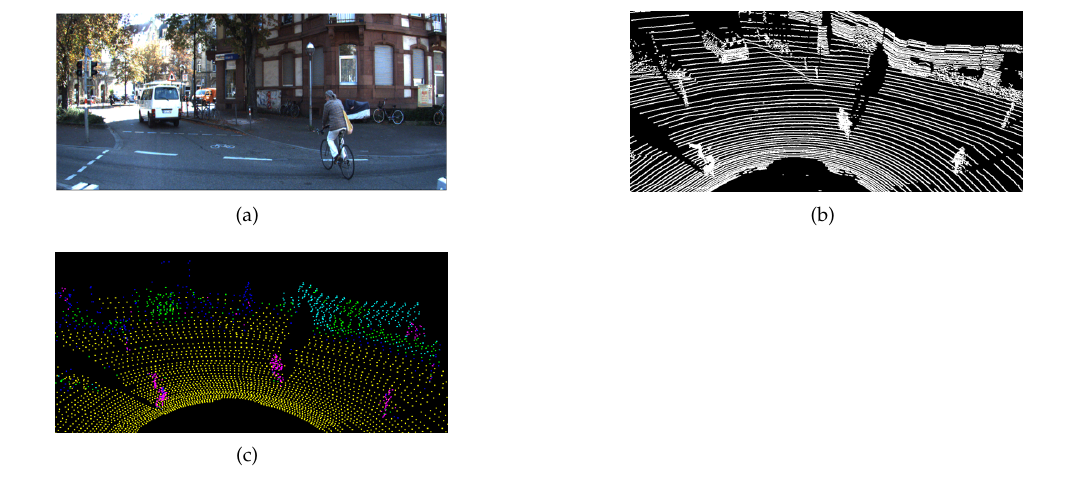
Figure 7. Segmentation evaluation on ( a ) the KITTI image and ( b ) the KITTI raw point cloud. ( c ) Point cloud segmented using the generated sP 2 image.